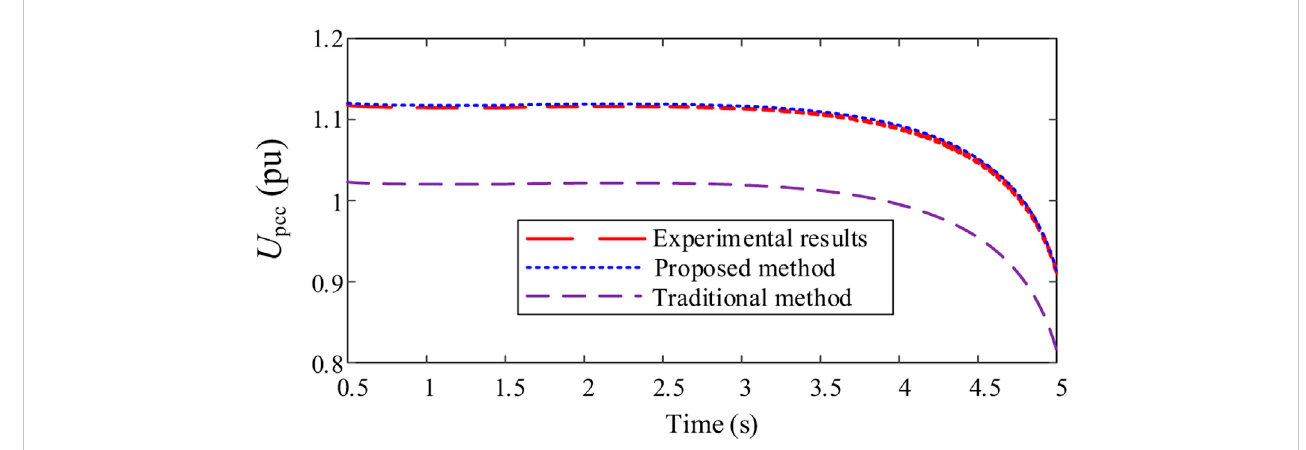
FIGURE 9 Comparison of different voltage models with experimental results.